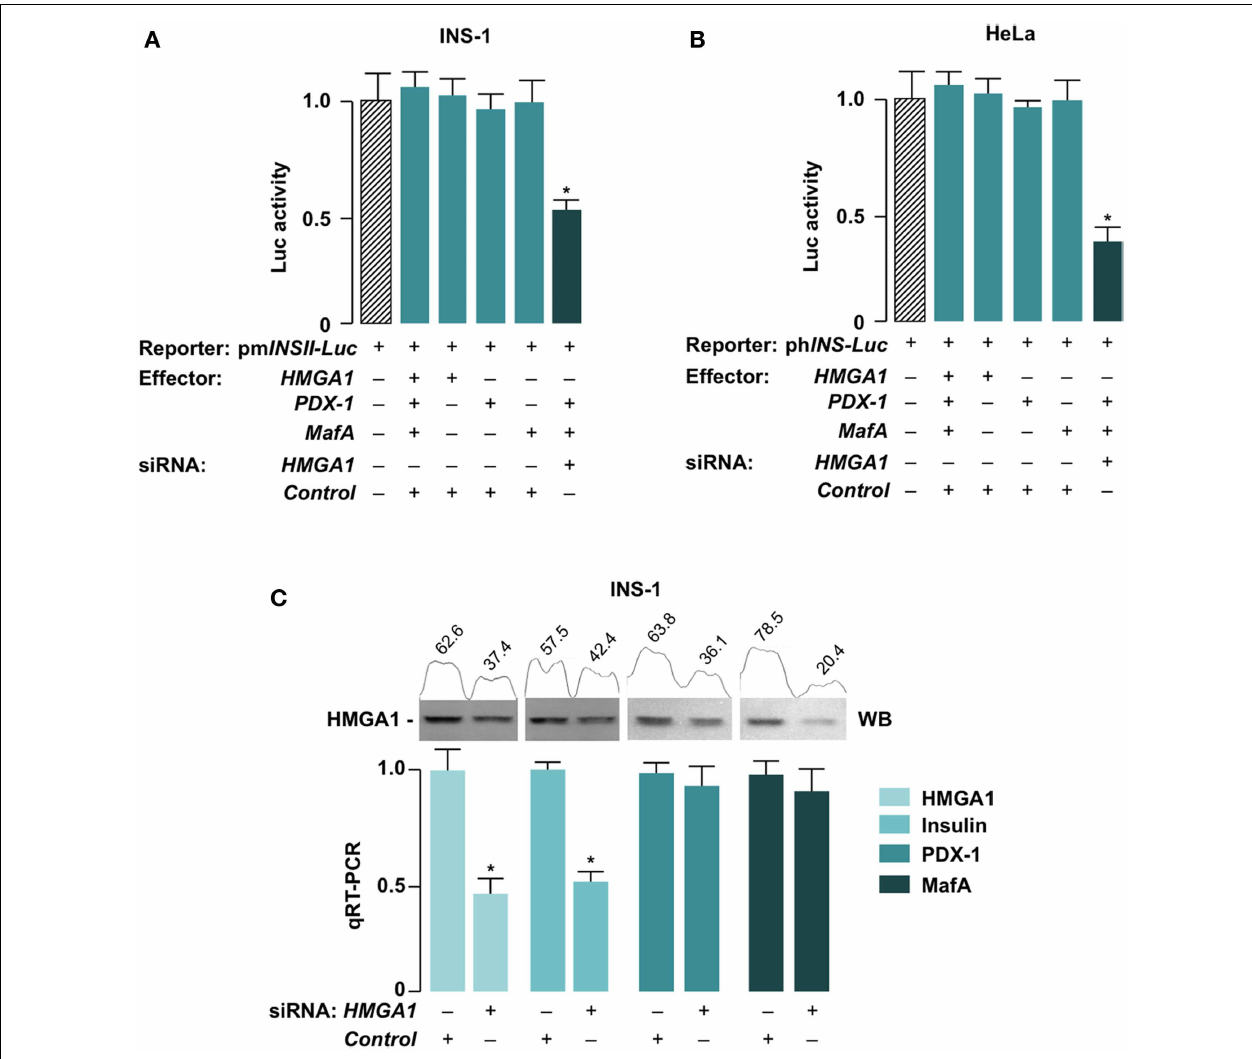
against HMGA1 or a non-targeting control siRNA, and mRNA levels for HMGA1, Insulin, PDX-1, and MafA were measured by quantitative RT-PCR (qRT-PCR). Results are the mean ± SEM of at least three separate transfections, each in triplicate. * p < 0.05 versus the relative control. Western blots (WB) of HMGA1, either before or after HMGA1 siRNA treatment, are shown in the autoradiograms and are from four independent experiments. Densitometric slot blot analysis, using the ImageJ software program, is shown. Numbers on the peaks are the size of the corresponding slot as a percentage of the total size of the two slots in each